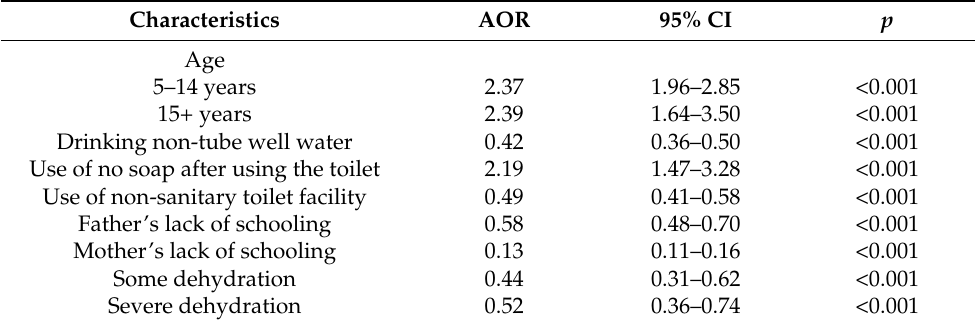
Table 4. Characteristics associated with the enrolled Rohingya refugee population compared to the enrolled neighborhood host-country population over three years in Teknaf and Ukhia sub-districts, Cox’s Bazar, Bangladesh 2018–2021.